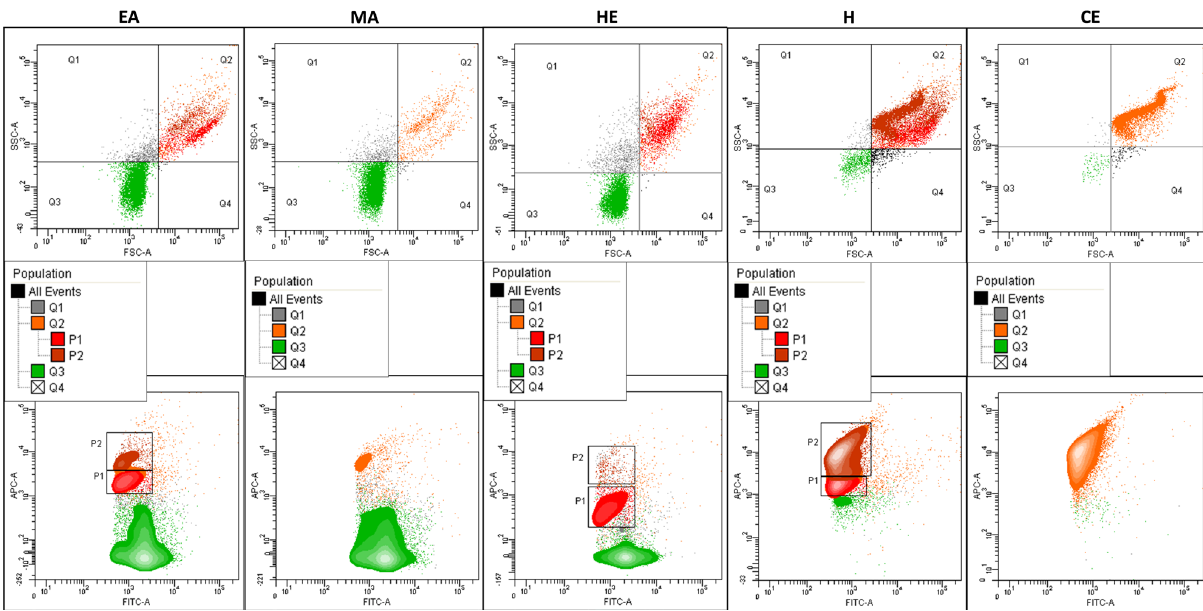
Figure 4: Diversity of SUV populations in terms of morphology and structure determined by flow cytometry. Bivariate contour plots in the upper row for each population FSC-A vs SSC-A, lower row – FITC-A vs APC-A. Diagrams indicate the gating strategy (structure of defined sub- populations). Sub-populations P1 and P2 (discriminated within the Q2 region using TO/DiD staining) indicate higher structural diversity of